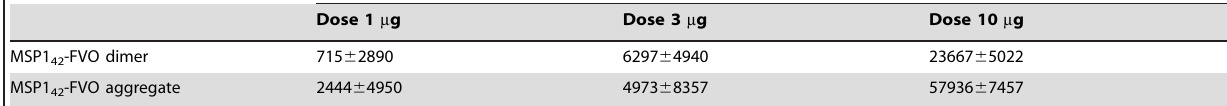
Table 1. Anti-MSP1 42 -FVO antibody titers in mice.